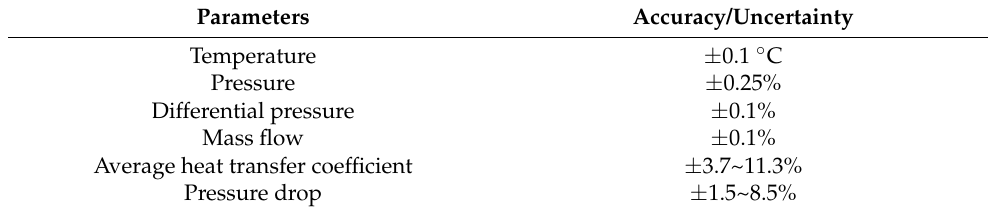
Table 3. The estimated